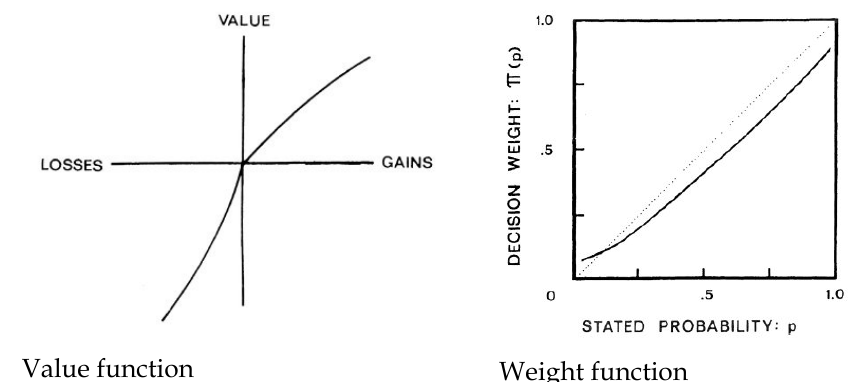
Figure 2. Value function and weight function ( Kahneman and Tversky, 1979